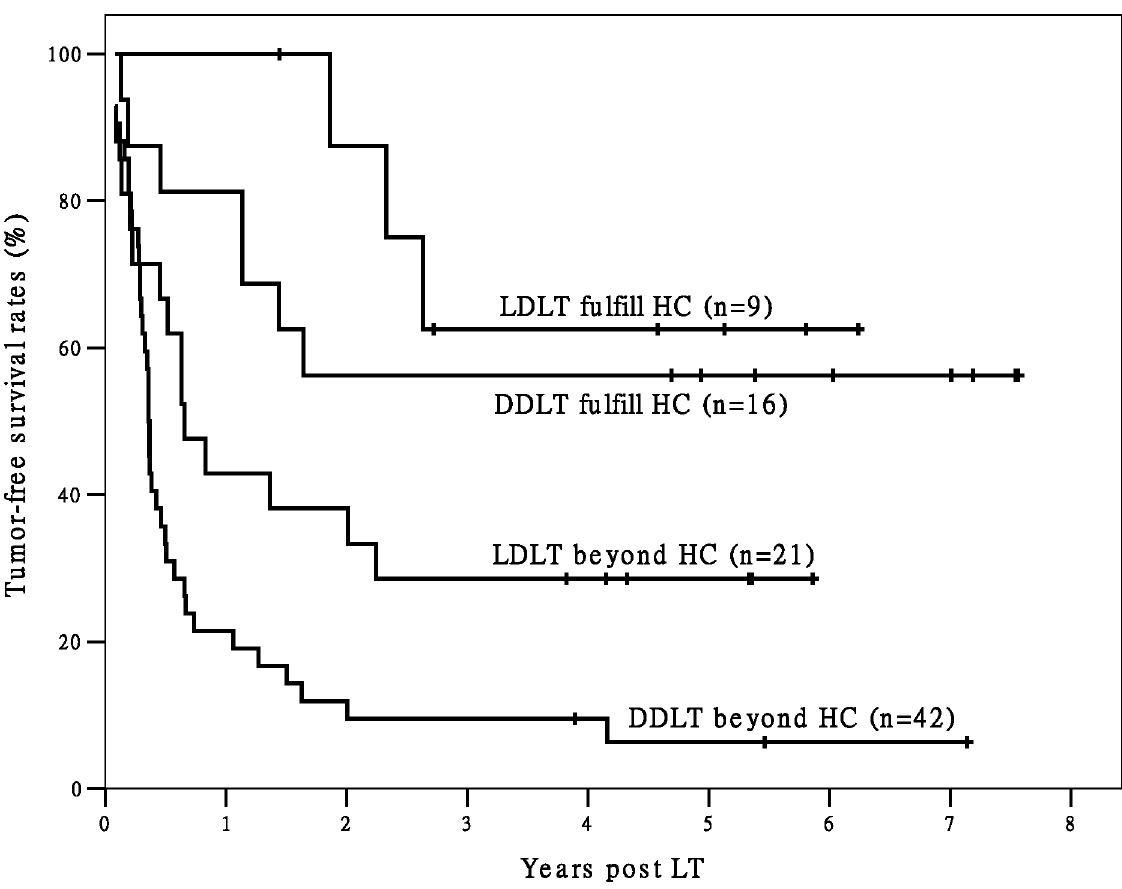
Figure 4. The survival curves of post-LT TFS of recipients beyond Milan criteria. There are significant differences in TFS between LDLT/ DDLT recipients fulfilling Hangzhou criteria and LDLT/ DDLT recipients exceeding Hangzhou criteria in all recipients beyond Milan criteria (both P , 0.05). Abbreviation: HC, Hangzhou criteria; TFS, tumor-free survival; LDLT, living donor liver transplantation; DDLT, deceased donor liver transplantation;